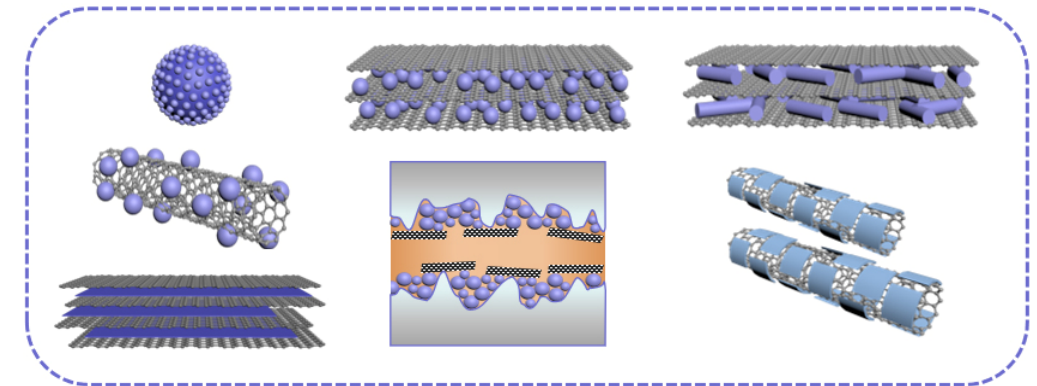
Fig. 16 Diagram of synergy effects with different